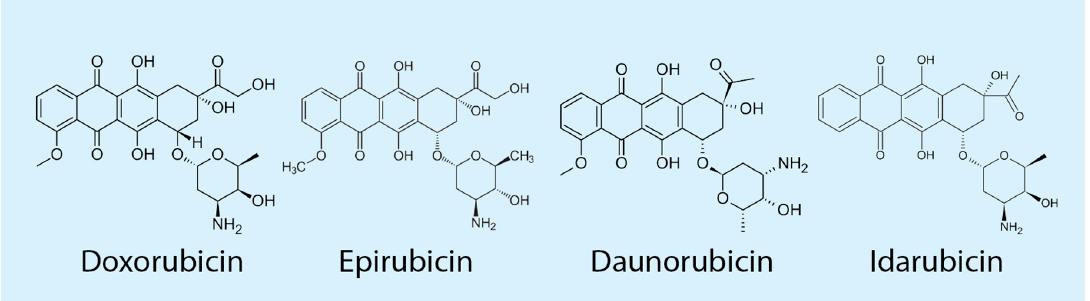
Figure 1. Chemical structures of the most clinically-used anthracyclines.